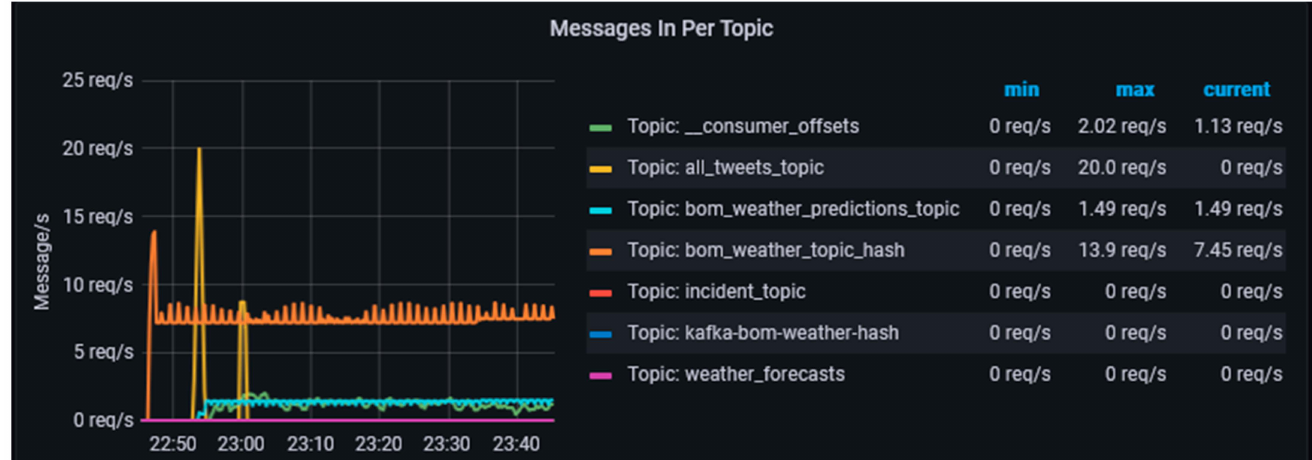
Figure 5. Messages in Per Topic identifying the data volume coming into the data-harvesting cluster.